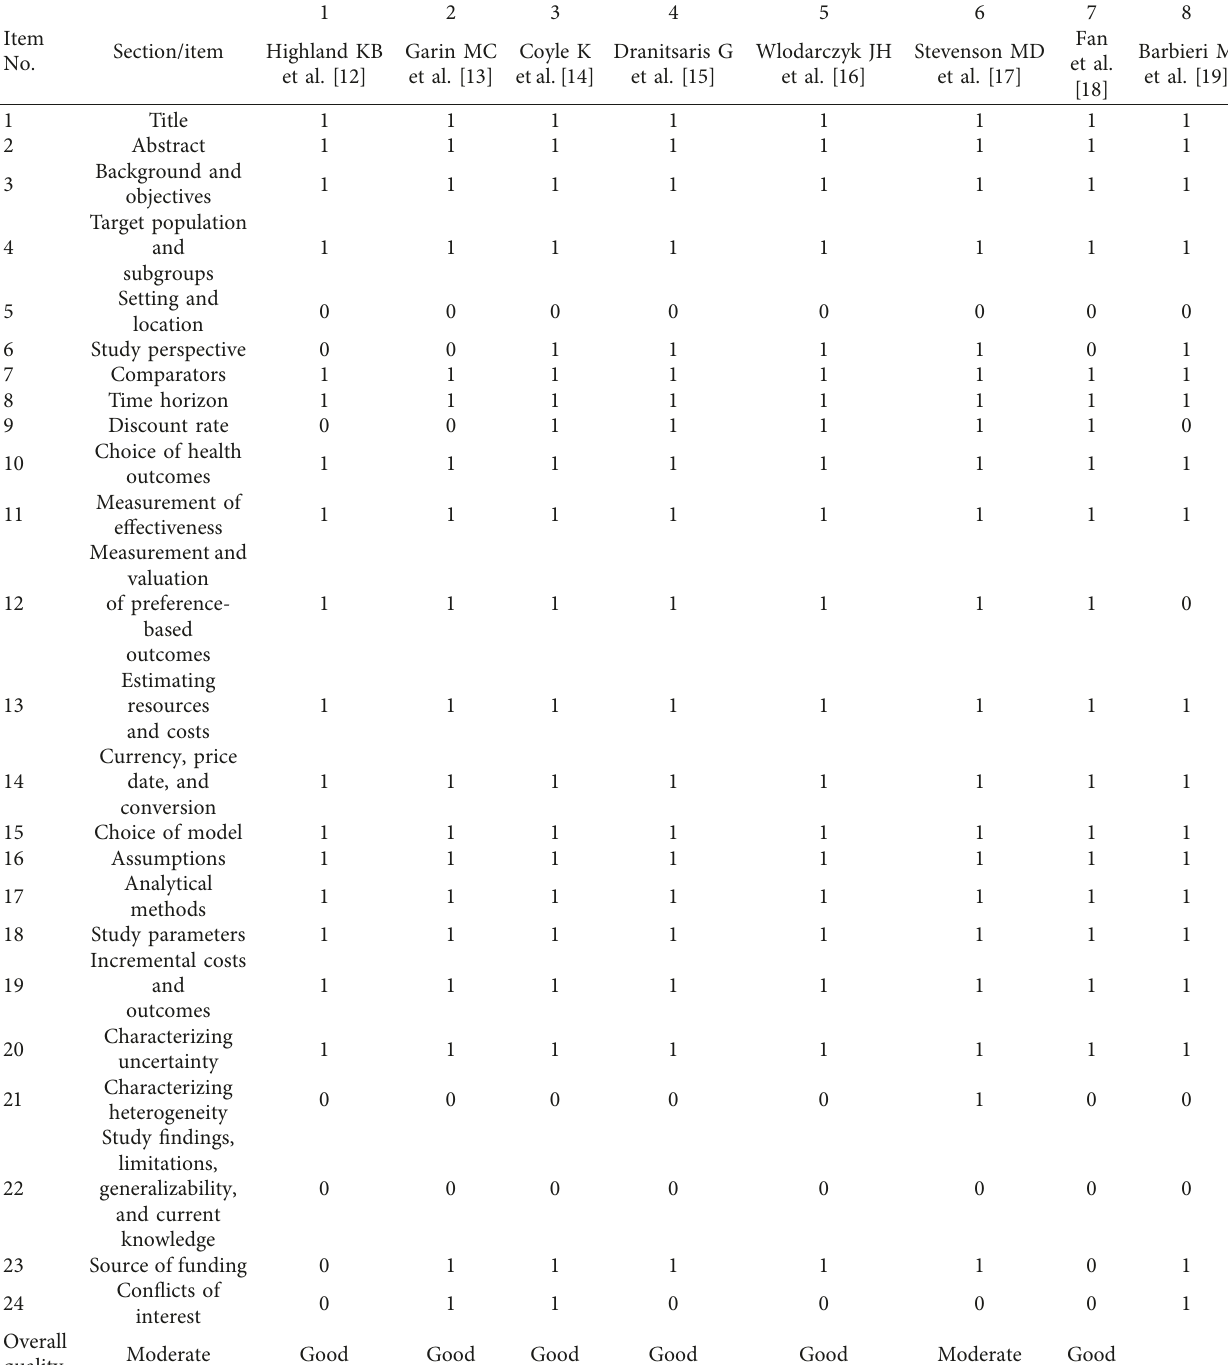
Table 2: Quality of the economic evaluations (as assessed by the CHEERS